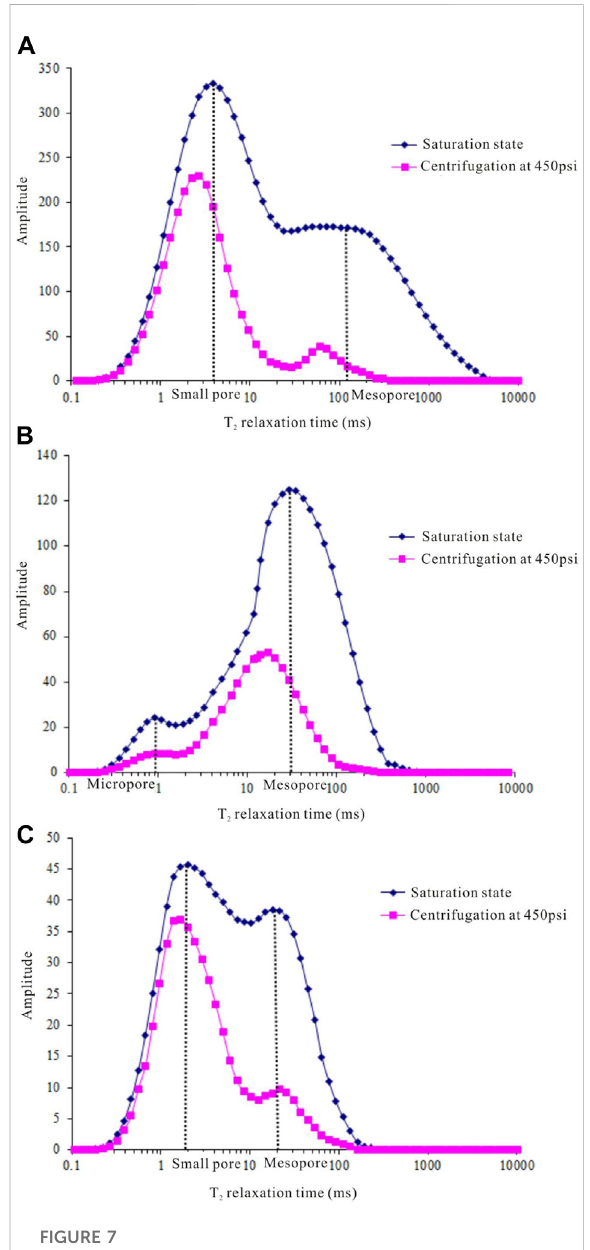
FIGURE 7 Three typical NMR curve types for Jurassic reservoirs.